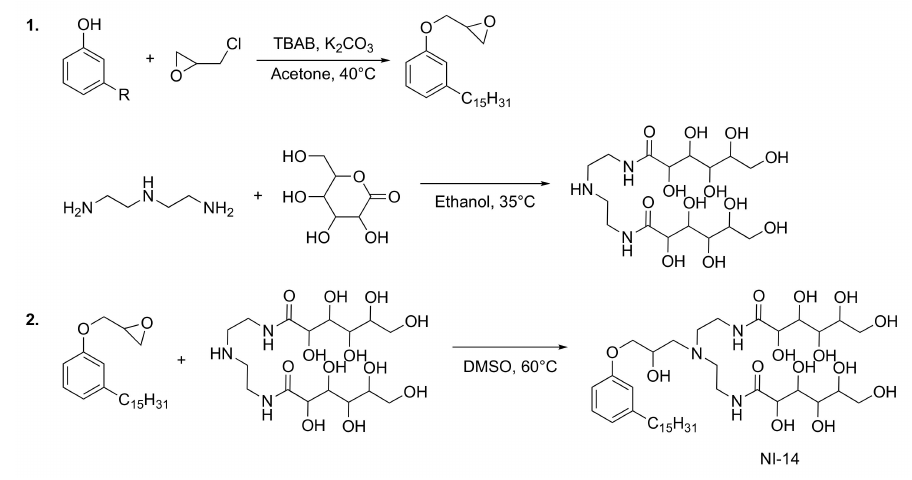
Scheme 44. Synthesis of cardanol-based surfactant with glucosamine as polar group. Cardanol can also be functionalized by longer saccharides, such as chitosan oligomers [138] (Scheme 45).